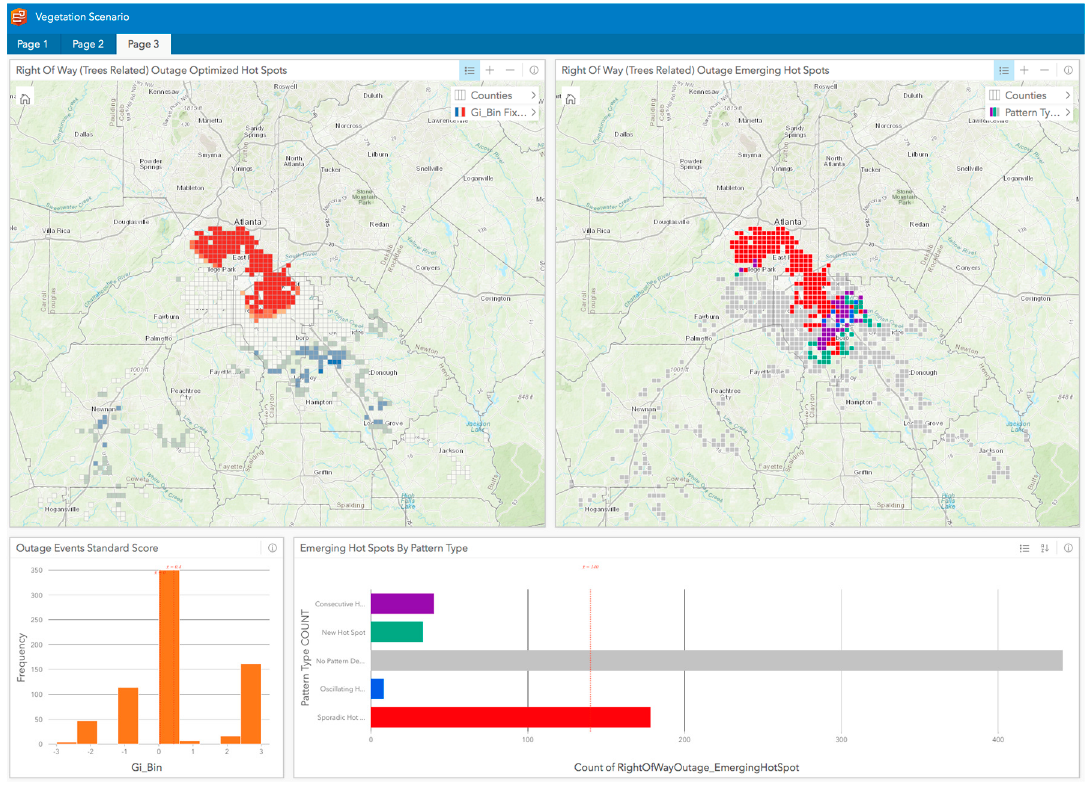
Figure 9. Challenge 2—Vegetation Scenario Workbook—Page 3.